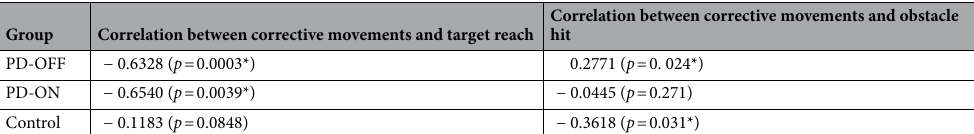
Table 6. Correlation between corrective movement and target hit, corrective movement and obstacle hit. Spearman correlation was applied; the table indicates the correlation coefficient ( r s ) and the corresponding p -value; * indicates statistical significance.